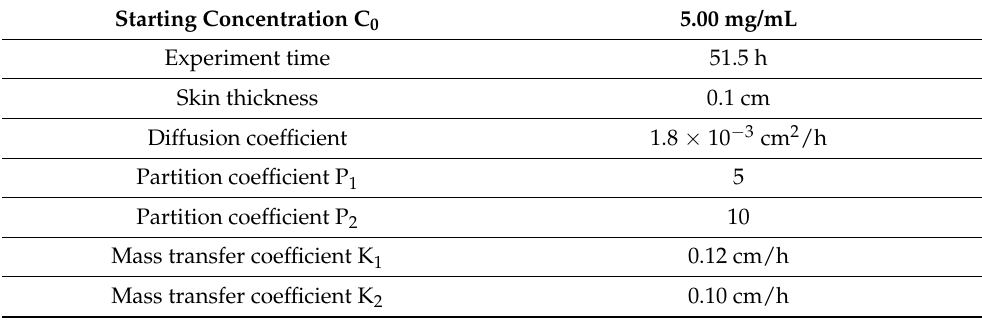
Table 3. Estimated parameter values for simulations of diclofenac at 32 °C.